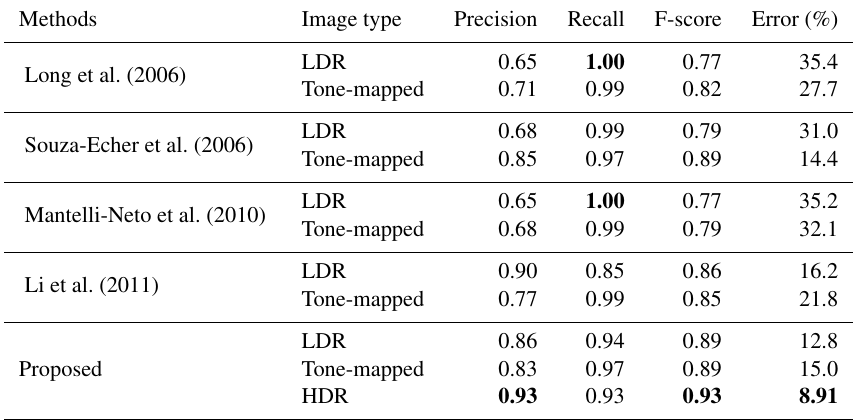
Table 2. Benchmarking results. The average scores across all the images are reported for the various methods. The best performance accord- ing to each criterion is indicated in